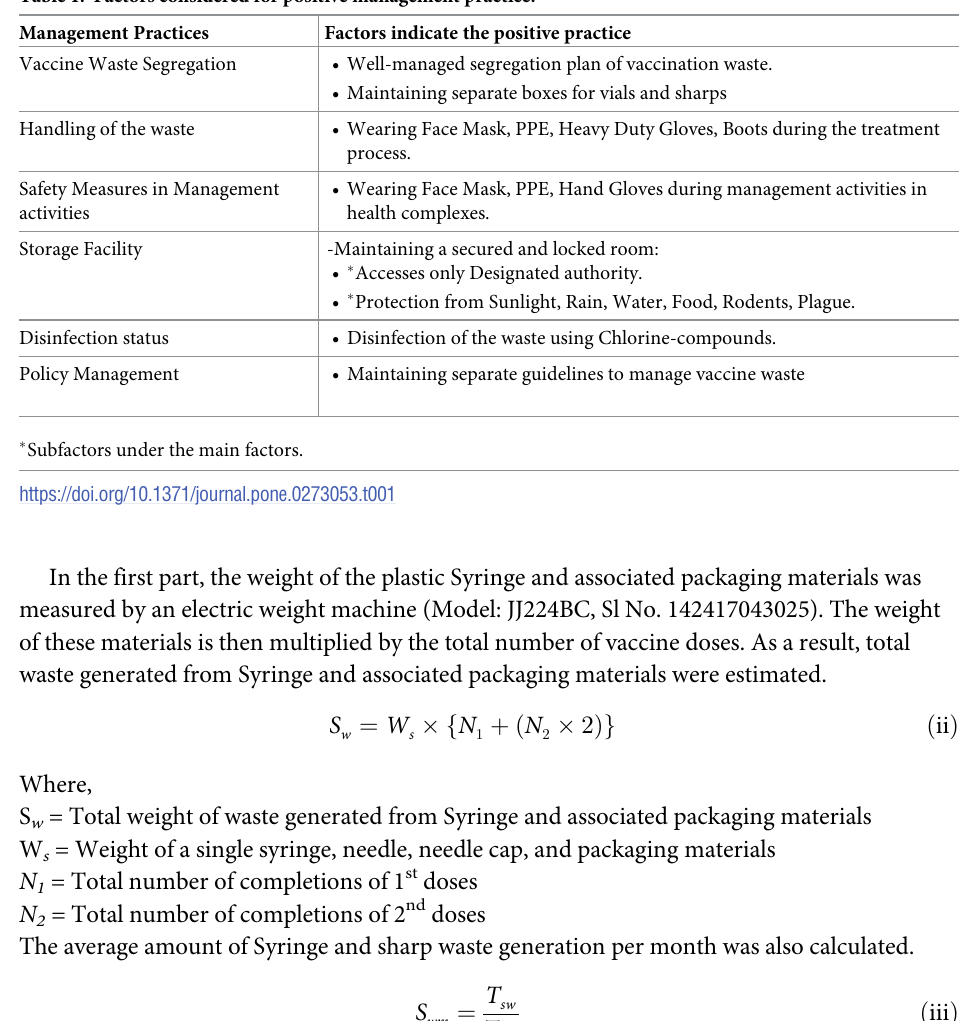
Table 1. Factors considered for positive management